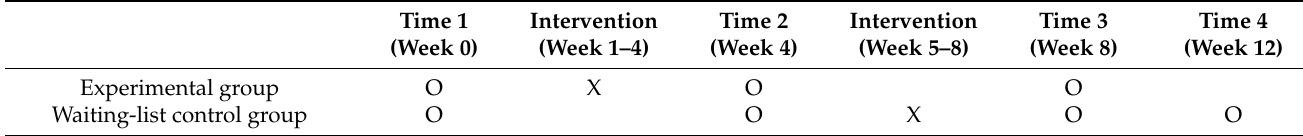
Table 1. The design of the